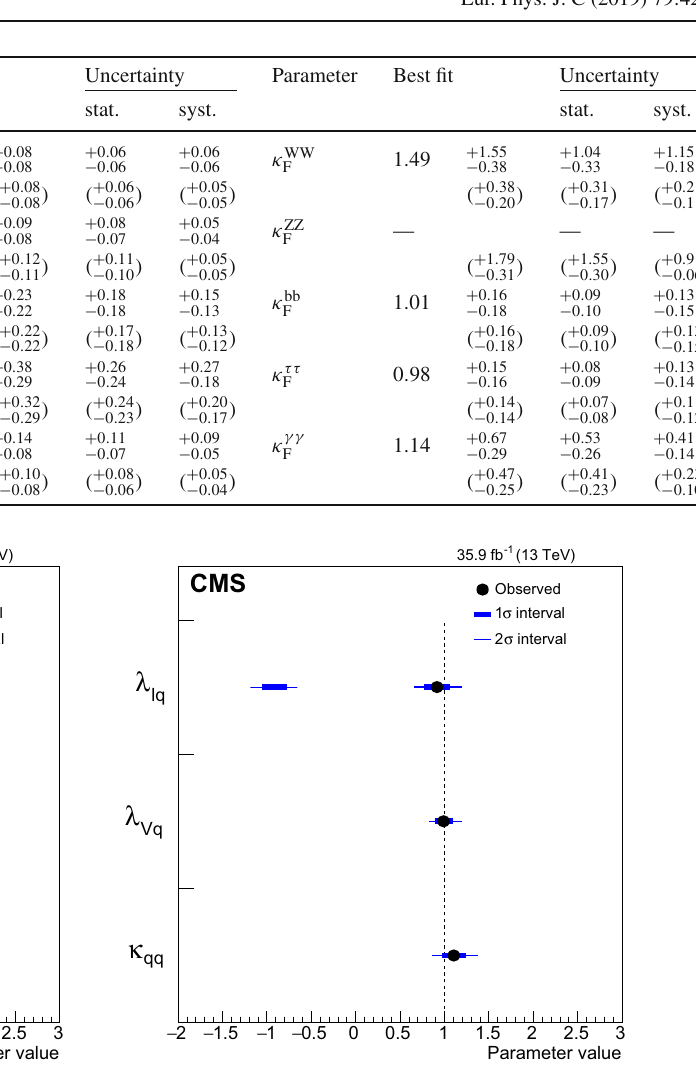
Fig. 18 Summary plots of the 3-parameter models comparing up- and down-type fermions, and floating the ratio of the vector coupling to the up-type coupling (left) and comparing lepton and quark couplings κ 2 /Γ H . Also shown are the results of the fit where the ratio u of the coupling to leptons and to quarks λ lq = κ l /κ q is deter- mined along with the ratio λ Vq = κ V /κ q and κ qq = κ 2